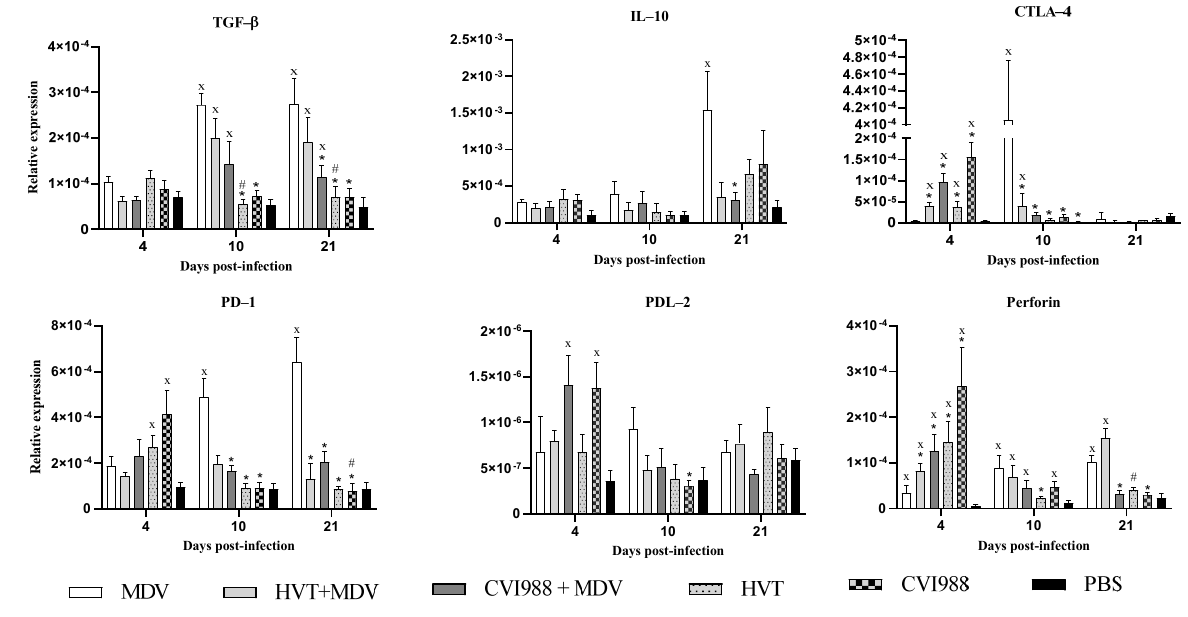
Figure 4. Relative expression of the immunoregulatory genes in feathers. Gene expression of TGF- β , IL-10, CTLA-4, PD-1, PDL-2, and perforin in feathers was determined based on the expression of β -actin at 4, 10, and 21 dpi. Logarithmically transformed data were analyzed by two-way ANOVA and Tukey’s post-test. Y -axis indicates the geometric mean of relative expression ± standard error of the mean. If p- value was ≤ 0.05, it was considered statistically significant when compared with PBS (x) or MDV (*) or HVT+MDV vs. HVT (#) or CVI988+MDV vs. CVI988 (#).